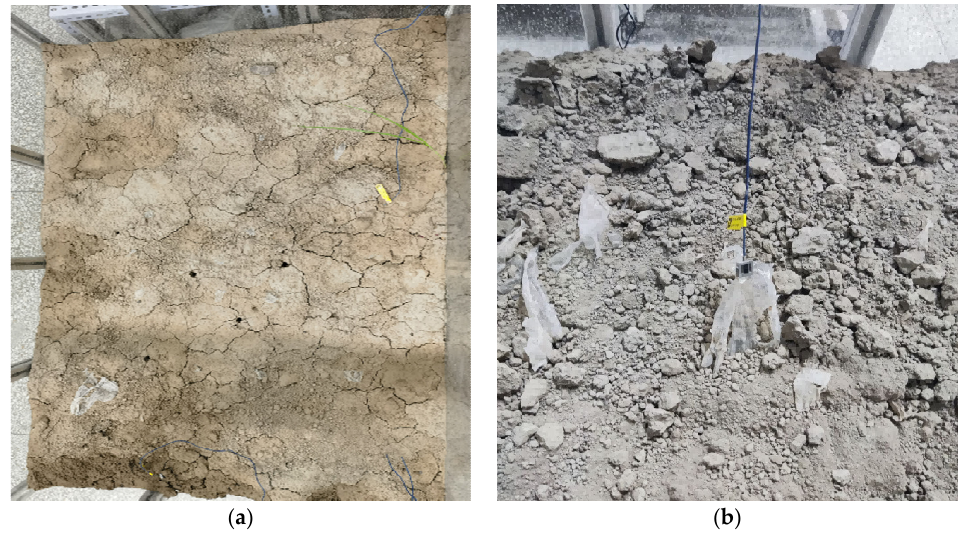
Figure 6. Experimental study on the influence of film lifting force and recovery rate under the condition of cutter tooth scarification. ( a ) Dry wet cycle test without loose soil; ( b ) Test of film removal and recovery under the condition of knife tooth scarification. Table 5. Results of variance analysis of influence of various factors on residual film recovery index after soil loosening.